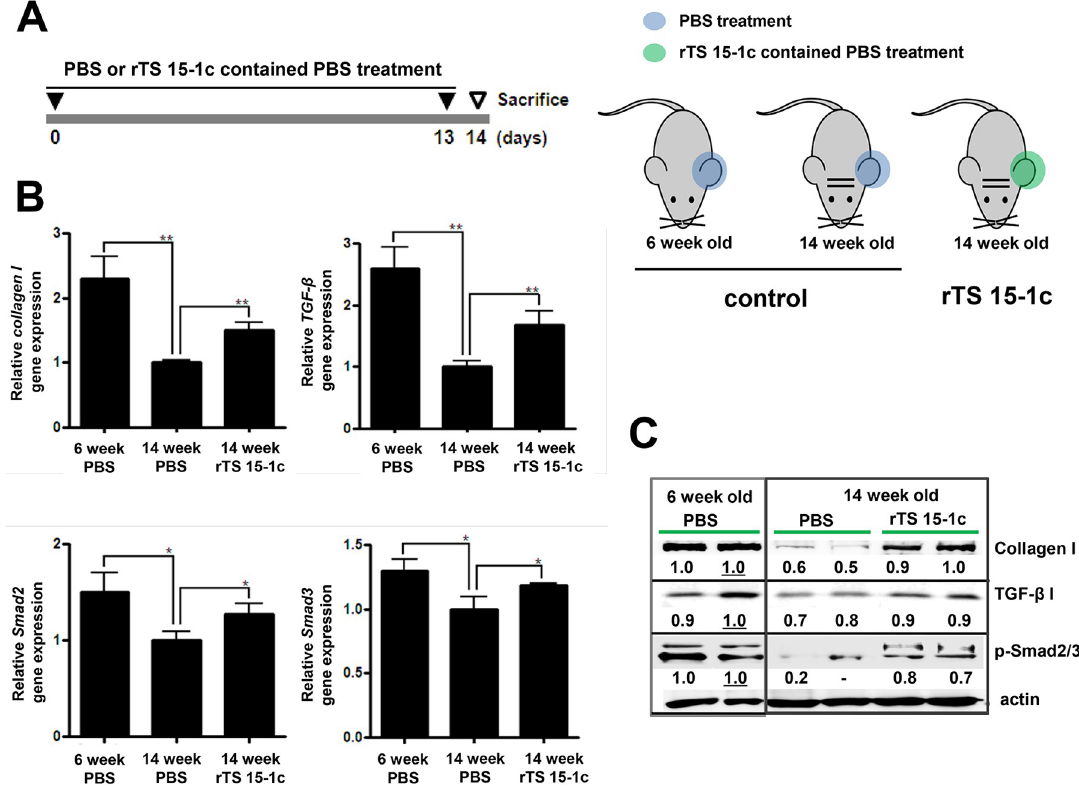
Fig 7. Evaluation of collagen I and TGF- β signaling pathway-related protein expression after treatment of recombinant TS 15-1c protein on natural aged mice. (A) Schematic schedule of the purified TS 15-1c treatment. The PBS (blue color) and 30 μ g rTS 15-1c contained PBS (green color) were treated daily on ears of 6 week or 14 week old mice. The total RNA was extracted from the sample treated ears, and cDNAs were synthesis according to manufactural protocols. (B) The gene expression levels of collagen I , TGF- β 1 , and Smad2/3 were analyzed via real-time PCR. ( � ; P < 0.05, �� ; P < 0.01, n = 3 to 5 mice/group, these were representative results from three independent experiments). (C) The gene expression levels of collagen I , TGF- β 1 , and Smad2/3 were analyzed by western blot